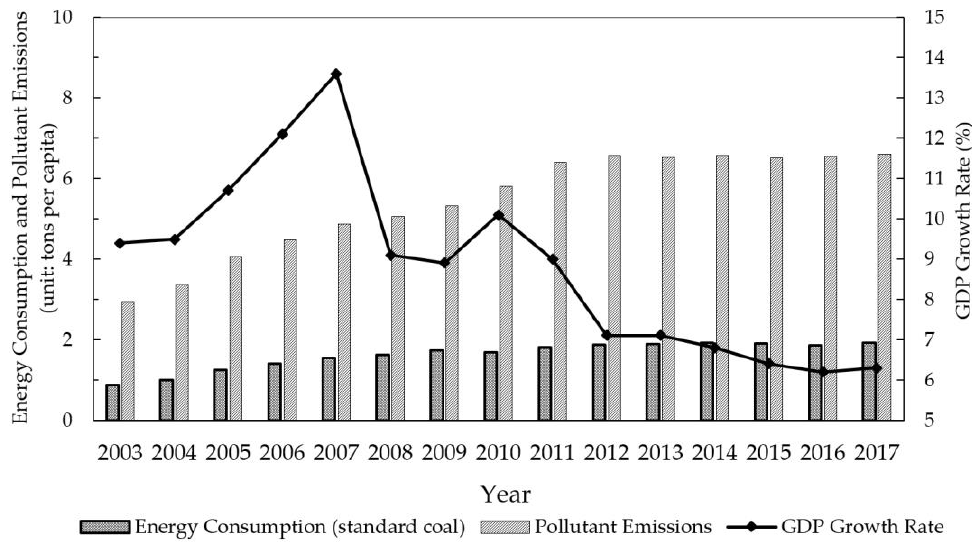
Figure 1. Trends of China’s energy consumption, pollutant emissions, and GDP growth. Source: author’s calculation with data from China Statistical Yearbook (2004–2018).